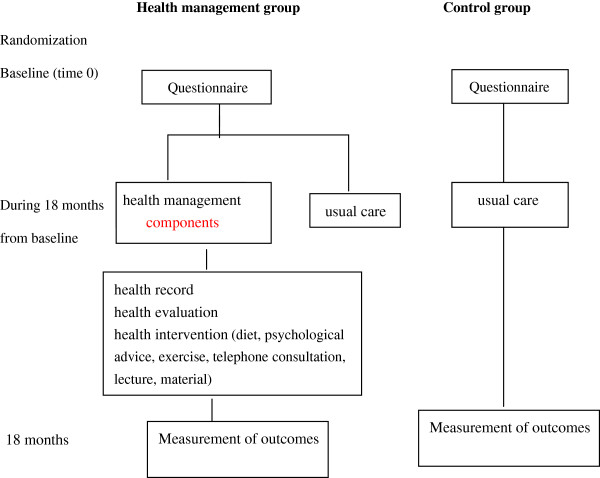
Graphical depiction of the intervention.